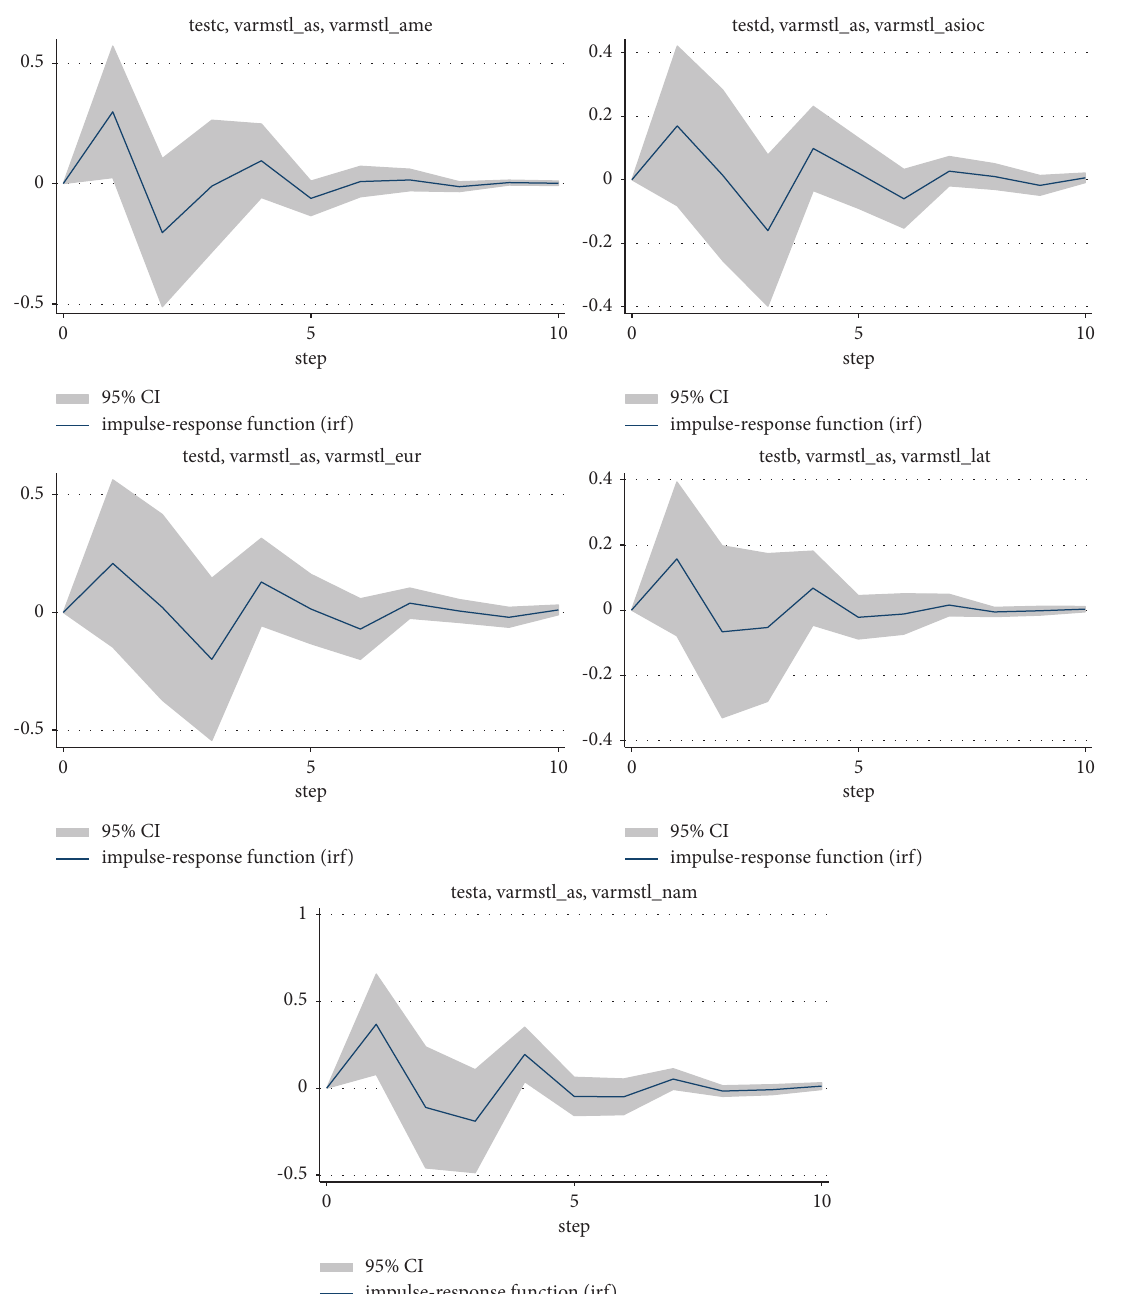
Figure 4: Impulse-response graphs. This figure depicts the impulse-response exercise from a shock in the global MSTL (varmstl_global) over the MSTL of North America (varmstl_nam), Latin America (varmstl_lat), America (varmstl_ame), Europe (varmstl_eur), and Asia- Oceania